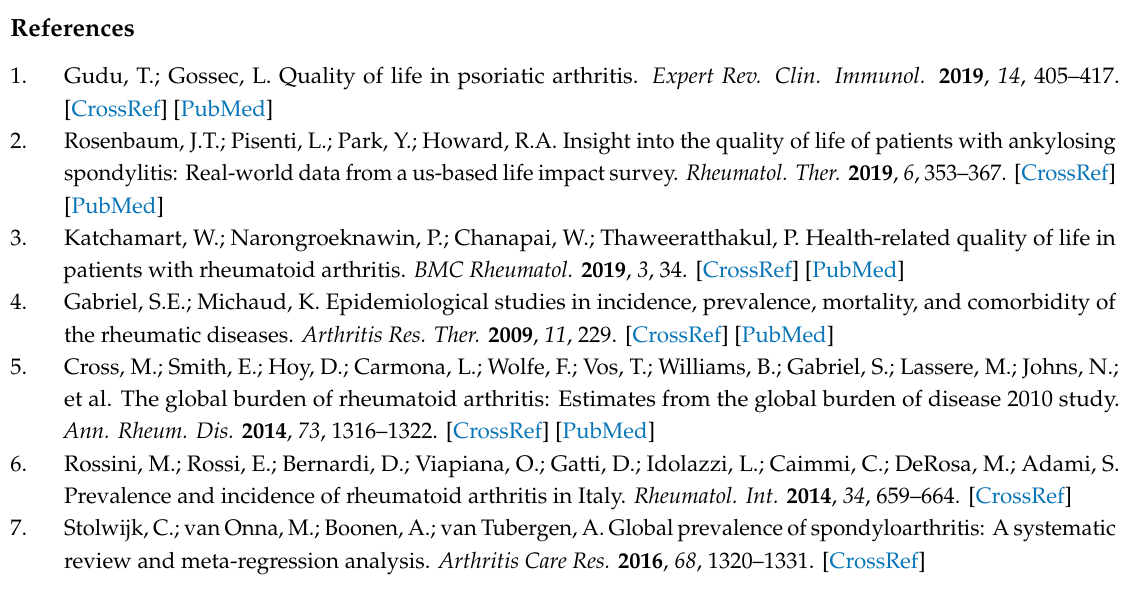
Table S1: Adverse event distribution by bDMARDs according to MedDRA ® System Organ Class and Preferred Term